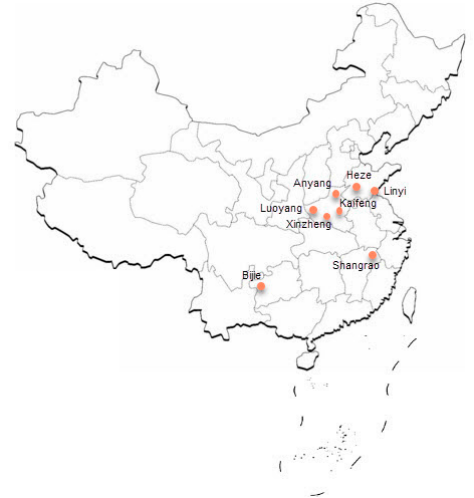
Figure 2. Location of the study area.